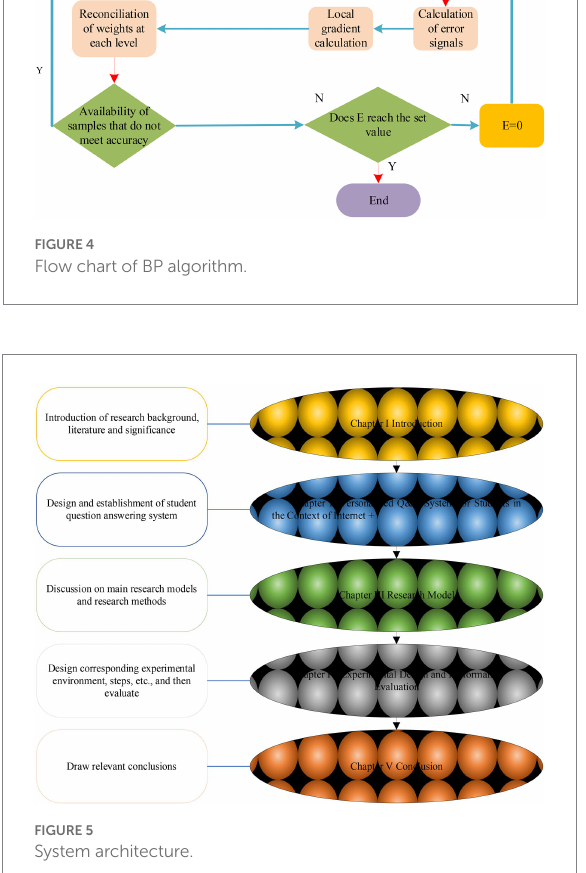
FIGURE 5 System architecture.